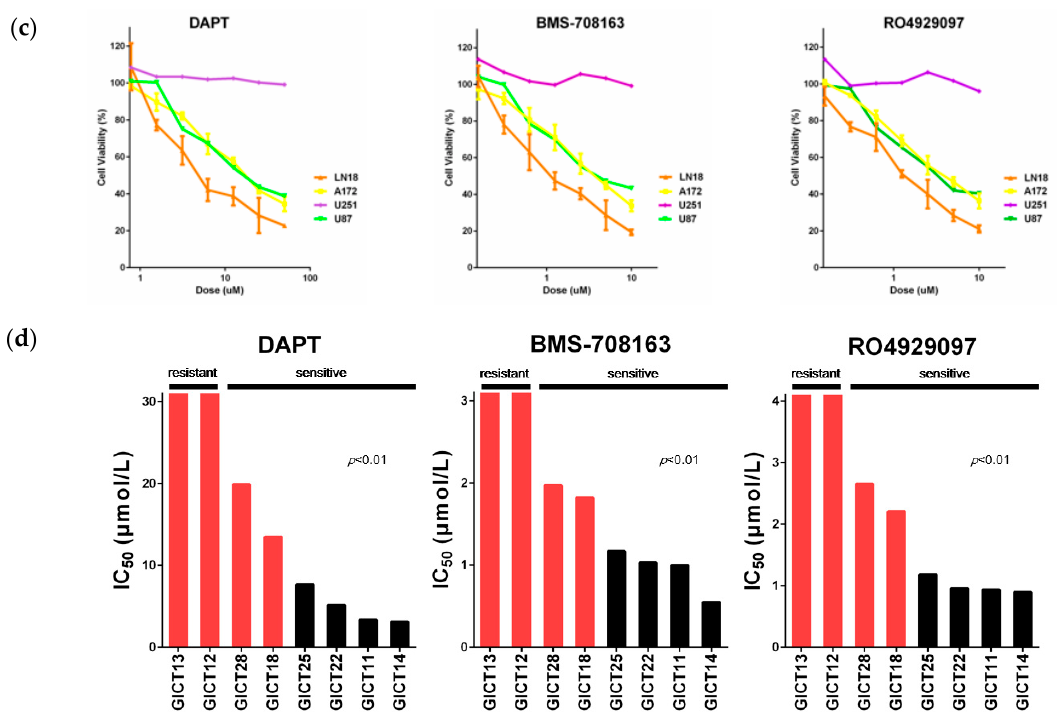
Figure 1. γ -Secretase inhibitors (GSIs) showed dose-dependent growth inhibition of glioma tumor-initiating cells (GICs). ( a ) A panel of GIC lines was treated with various concentrations of the GSIs. Cells were treated with increasing concentrations of GSIs in triplicate wells for 72 h, and cell viability was assessed with the CellTiter-Blue assay. Cell viability in the vehicle control was considered to be 100%; ( b ) GSIs showed dose-dependent growth inhibition of glioma cells. A panel of glioma cell lines was treated with various concentrations of the GSIs. Cells were treated with increasing concentrations of GSIs in triplicate wells for 72 h, and cell viability was assessed with the CellTiter-Blue assay. Cell viability in the vehicle control was considered to be 100%; ( c ) Western blotting of the Notch signaling, AKT and PTEN in glioma cell lines. β -Actin was used as loading control; ( d ) Waterfall plot of IC50 values for eight GICs. These figures show that GSIs have a particular growth inhibition signature: some cell lines are very sensitive and others are relatively resistant.